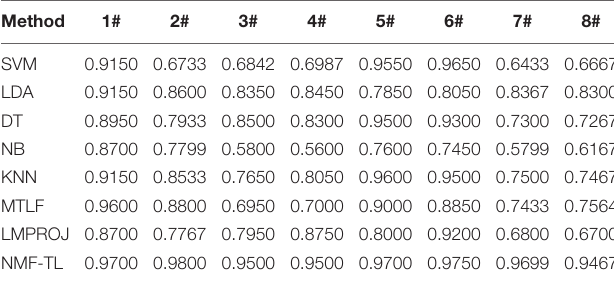
TABLE 3 | Classification accuracy comparison of 8 classifiers on datasets based on WPD feature extraction.